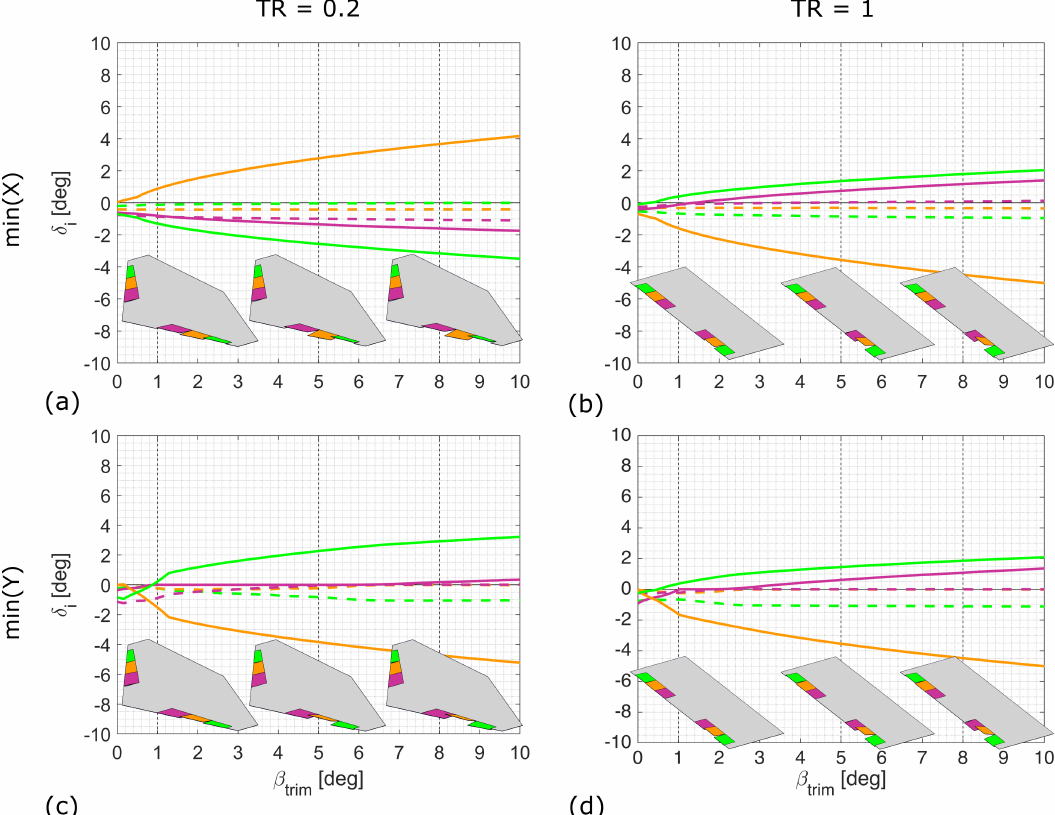
Figure 6. Deflection required to generate yawing moment to trim at a given sideslip angle, β trim , for a straight wing with objectives of maximising aerodynamic efficiency ( a , b ) and minimising aggregate control deflection ( c , d ) for a taper ratio 0.2 ( a , c ) and 1 ( b , d ). Dashed lines represent port surfaces and solid lines are for starboard surfaces. Positive deflections are defined as trailing edge down. For visualisation purposes, insets show deflections required to trim at one, five and eight degrees of